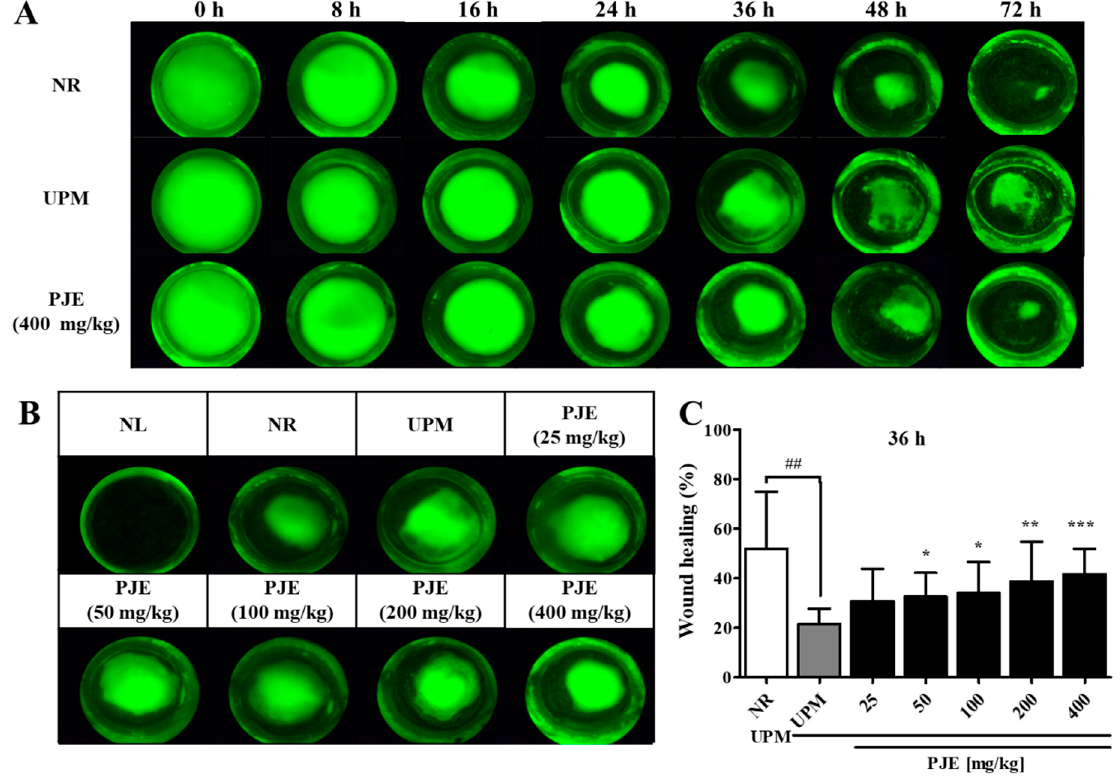
Figure 5. Effects of PJE in a corneal abrasion model after UPM exposure. PJE and UPM were used as pretreatments for 5 days, and 4 mm wounds were generated on the right cornea. Images were obtained at 0, 8, 16, 24, 36, 48 and 72 h by fluorescein staining. ( A ) Time course images of corneal wound healing in the normal right eye (NR, normal wound), UPM and 400 mg/kg PJE groups. ( B ) Representative images of each group at 36 h. ( C ) The wound healing areas were calculated and are presented as the means ± SD. ## p < 0.01 compared to NR; * p < 0.05, ** p < 0.01, *** p < 0.001 compared to UPM. Table 1. Time course observations of the changes in corneal wound healing areas after PJE treatment and UPM exposure. 0 h 8 h 0h